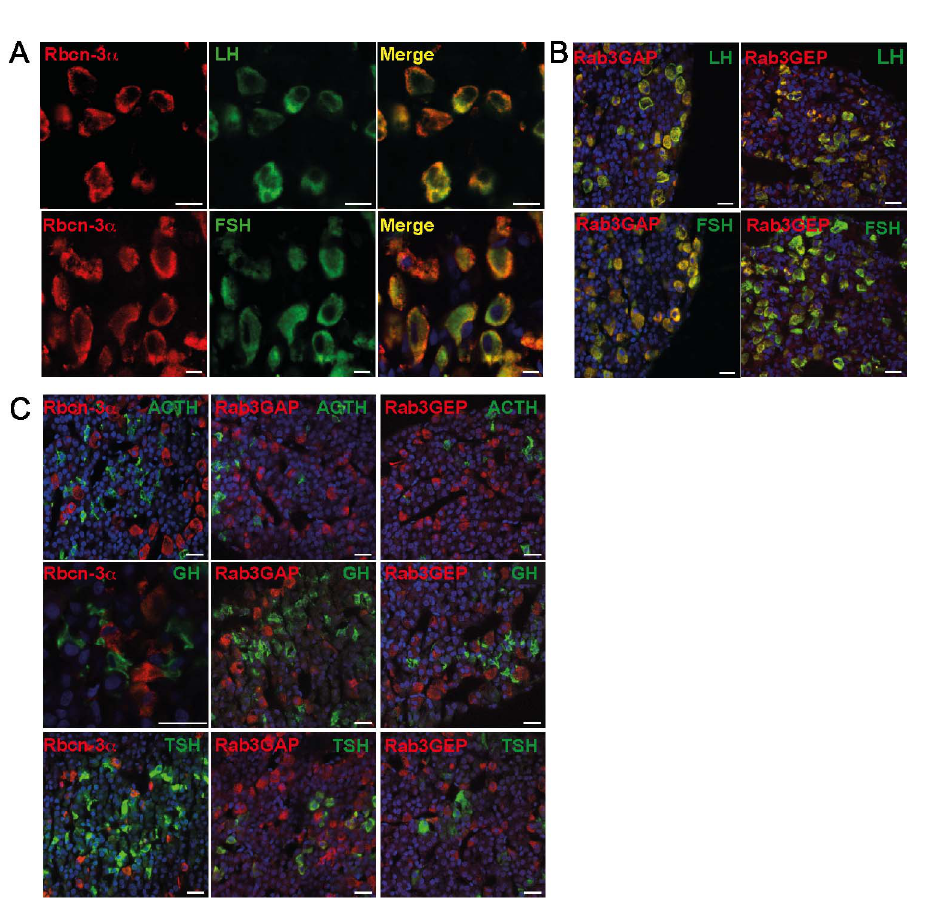
Figure 3. Rbcn-3 a is specifically expressed in gonadotropes in the pituitary. (A) Double-immunostaining for Rbcn-3 a and LH or FSH in the rat pituitary gland showed that Rbcn-3 a was expressed in gonadotropes. Scale bars, 10 m m. (B) Double-immunostaining for Rab3GAP or Rab3GEP revealed that these two proteins were present in both LH- and FSH-expressing cells. (C) Immunostaining with antibodies against Rbcn-3 a , Rab3GAP, or Rab3GEP and ACTH, TSH, and GH showed that Rbcn-3 a , Rab3GAP, and Rab3GEP were not expressed in corticotropes, thyreotropes, and somatotropes. Scale bars, 40 m m. Red staining, antibodies against Rbcn-3 a , Rab3GAP, and Rab3GEP. Green staining, antibodies against pituitary hormones.